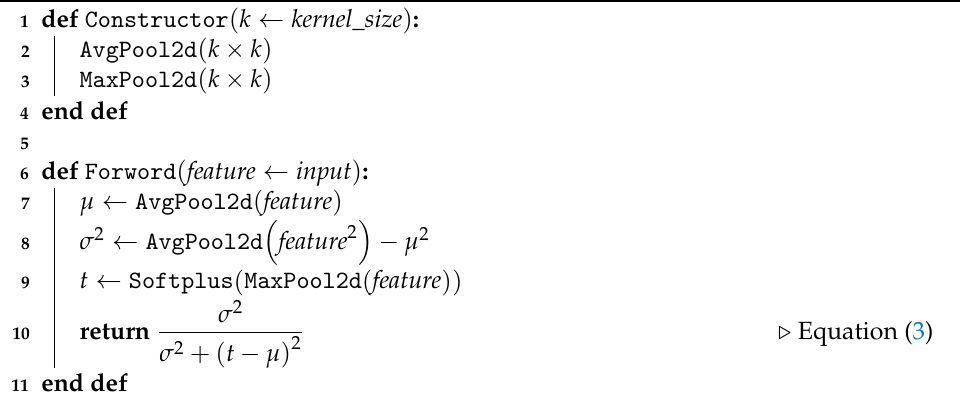
Algorithm 3: Pseudo code for the whole processing of Chebyshev pooling.